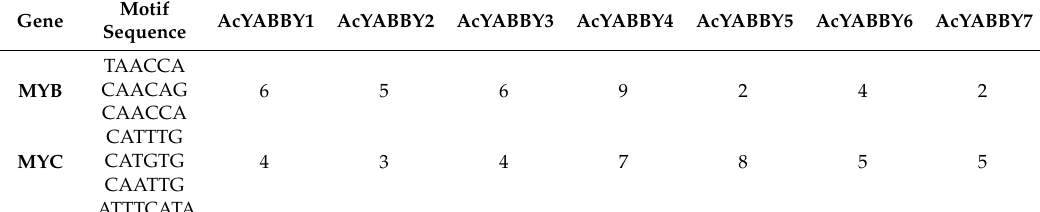
Table 2. Distribution of MYB, MYC and ERE cis -acting element in pineapple YABBY promoters.